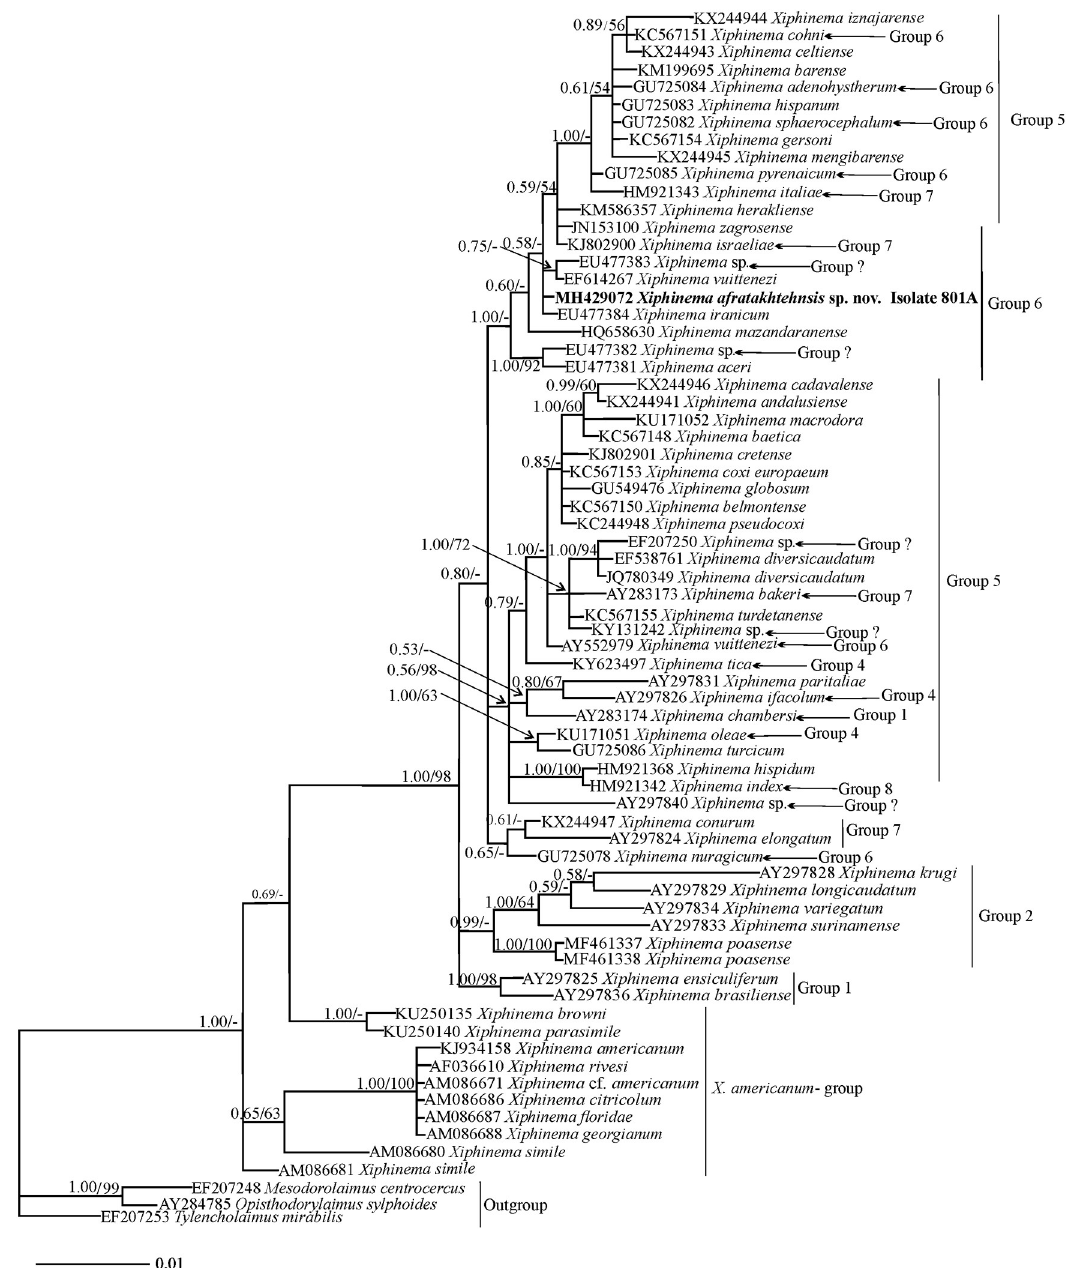
Fig 5. The 50% majority rule consensus trees from Bayesian inference analysis generated from the partial 18S rDNA dataset of Xiphinema afratakhtehnsis sp. nov. with the GTR+I+G model. Bayesian posterior probabilities and maximum likelihood bootstrap values are given for appropriate clades in the shape BPP/ML BS. Newly obtained sequences are in bold letters. Scale bar = expected changes per